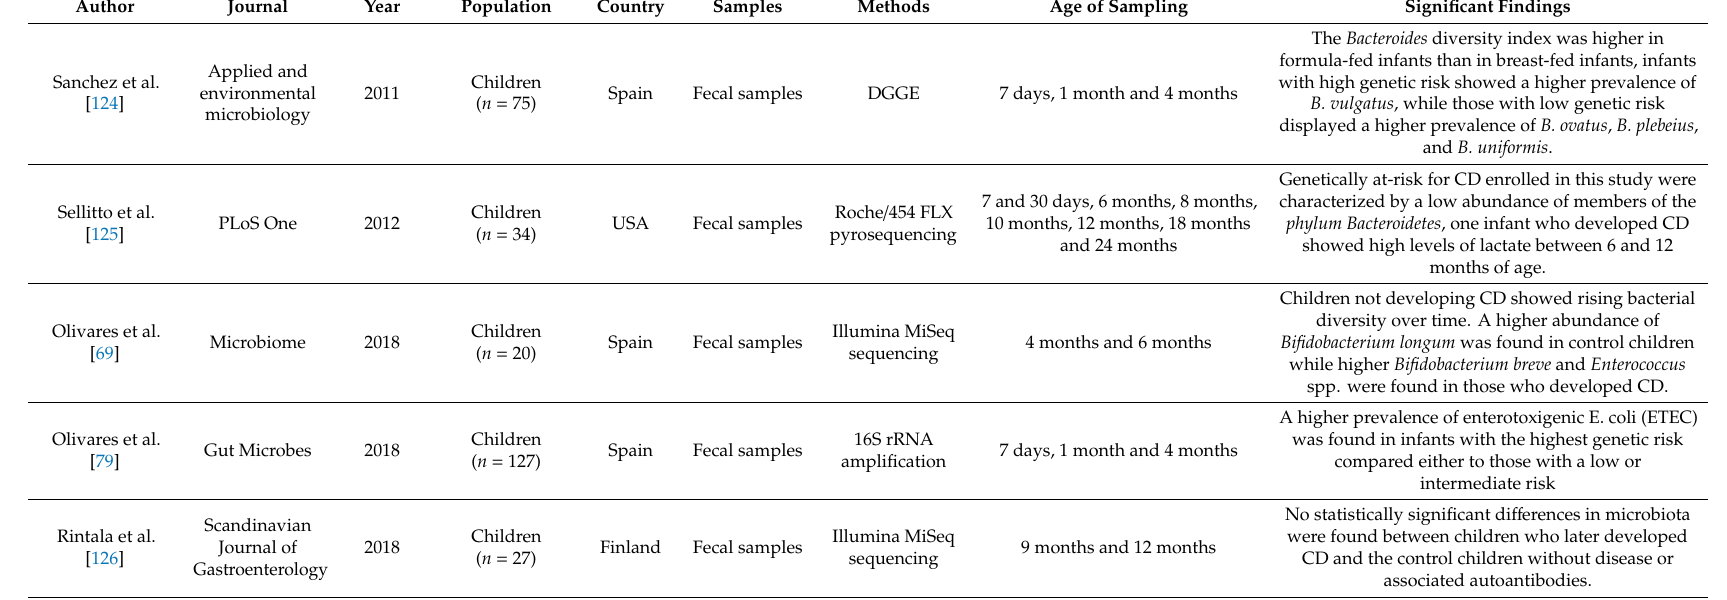
Table 2. Prospective studies on microbiota development in subjects at risk for